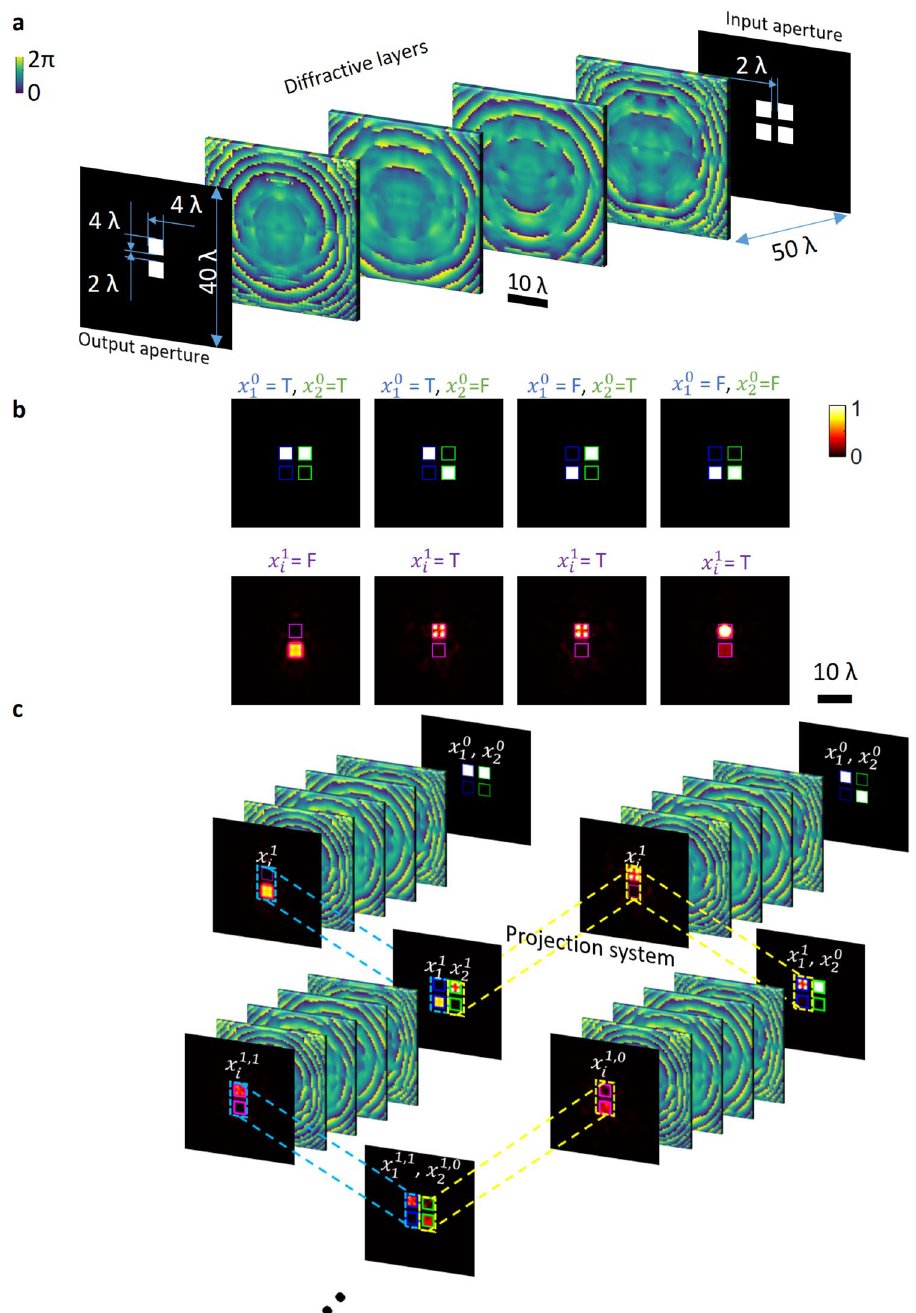
Figure 1. Schematic of cascadable all-optical NAND gates using diffractive networks. ( a ) Design of a cascadable diffractive NAND gate. ( b ) The input plane intensity profile of the diffractive NAND gate with all the possible combinations of ideal optical logical values, i.e., ( x 0 1 , x 0 2 ) = (T,T), (T,F), (F,T) and (F,F), as well as the corresponding optical intensity profiles at the output plane of the diffractive network, with output optical logical values of x 1 i =(F, T, T, T) respectively. ( c ) Schematic of cascading diffractive NAND